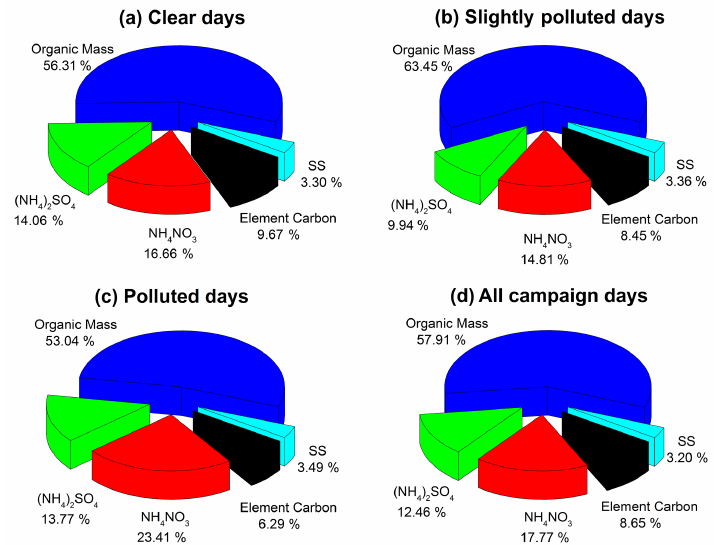
Figure 9. Average fractional contribution of each chemical composition to dry PM 1 . 0 extinction coefficient with respect to different pollution